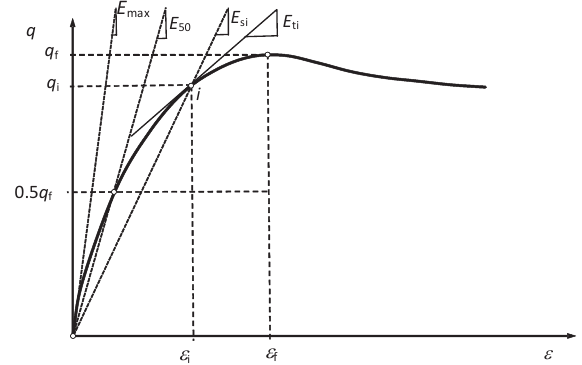
– secant Figure 1: Non-linear stress–strain characteristics: E s modulus, E – tangent t Fig. 1. Non-linear stress–strain characteristics: E s – secant modulus, E t – tangent modulus. In many cases of numerical analysis of geotechnical problems, each stage of the development of the state of stress and strain should be considered, dealing with strains in the range of  10 -3 . In this range, the variation in the deformation modulus is the greatest. Due to the technical conditions of the triaxial compression apparatus, the results of the tests determining the general deformation modulus E and its variability are not accurate enough, particularly, in the range of strain below 0.1%. In computational procedures, other measures of soil stiffness are used more